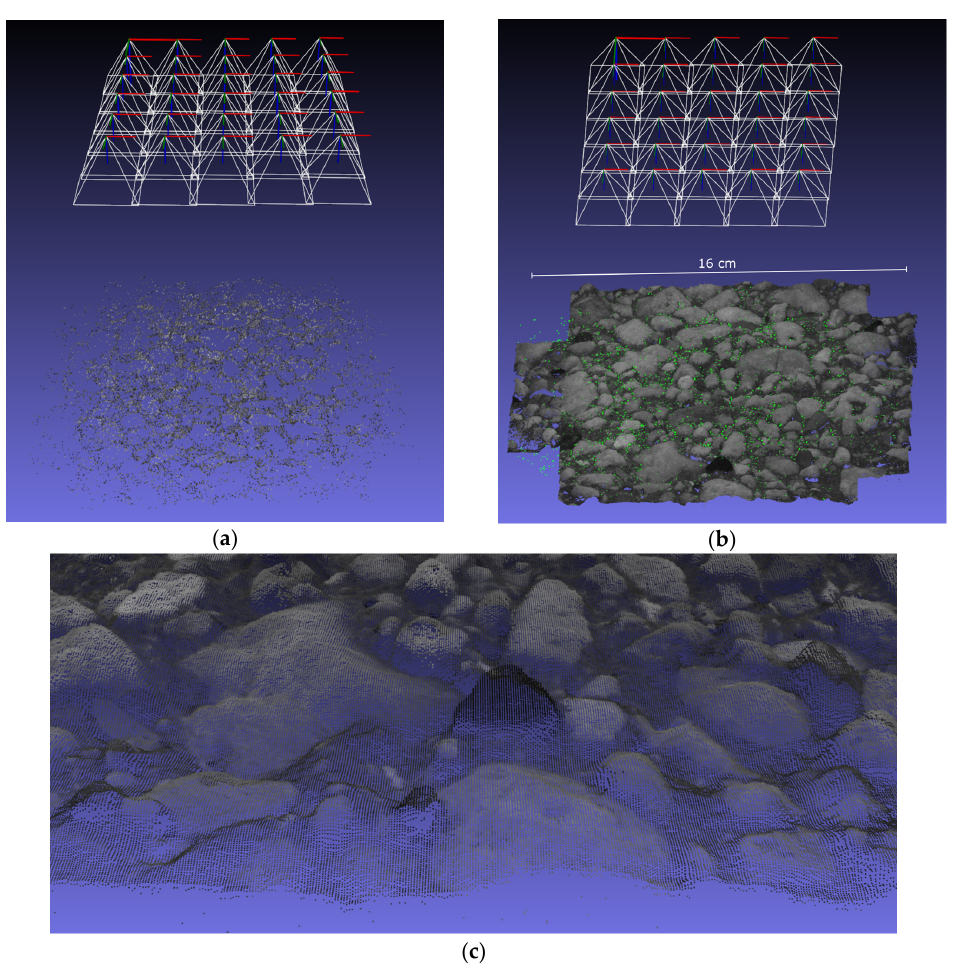
Figure 16. 3D point cloud reconstruction of a particular concrete specimen: ( a ) Reconstructed camera poses including the sparse point cloud after SfM procedure, ( b ) generated dense point cloud after Dense Image Matching (DIM), and ( c ) zoom-in of the dense point cloud.